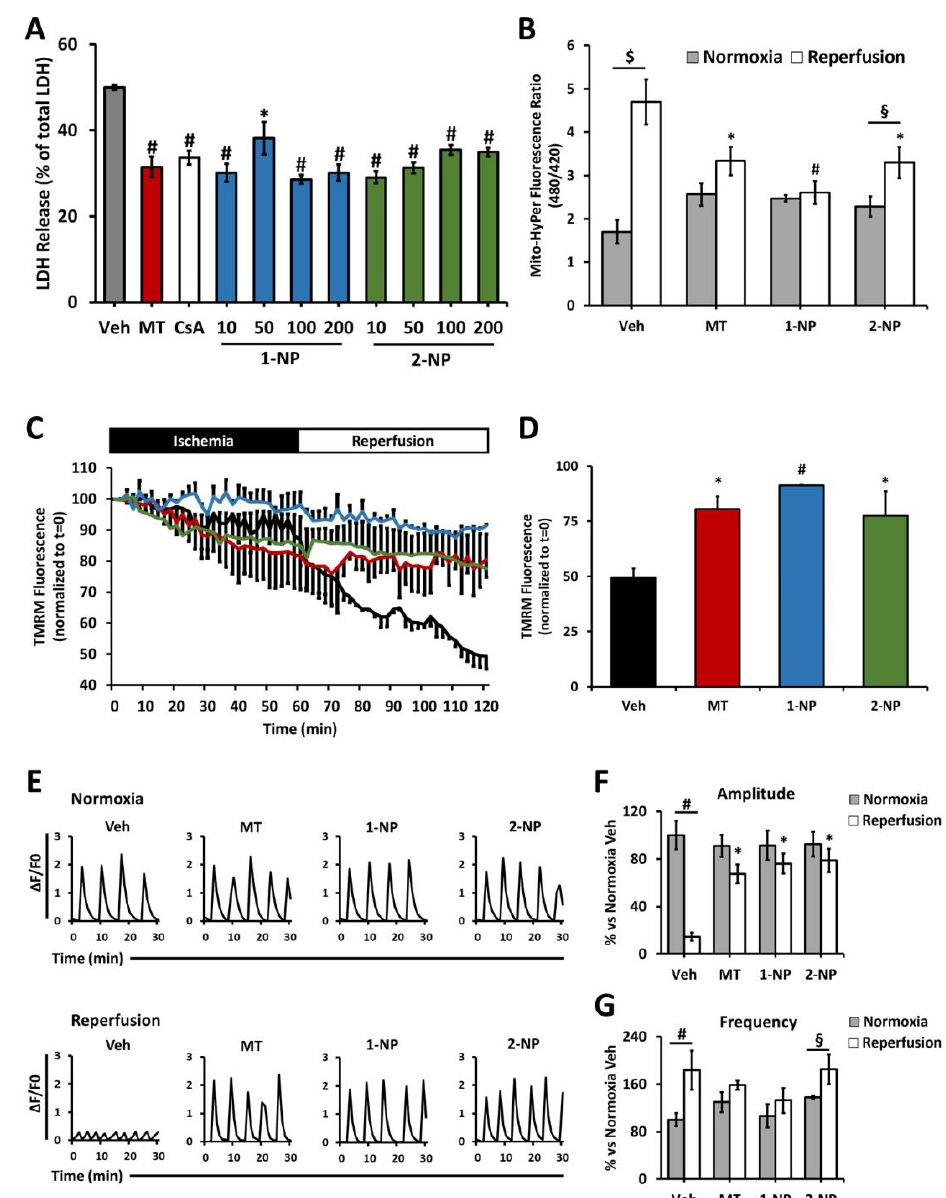
Figure 5. Poly(lipoic acid) NPs protect cardiomyocytes (RNVMs) from ischemia-reperfusion injury. ( A ) Cell death measured by LDH release in reoxygenation from isolated NRVMs. Cells were treated with different concentrations of either F127@ 1 -NP or F127@ 2 -NP. MitoTempo (MT, 10 µM) or cyclo- sporin A (CsA, 2 µM) were used as positive control. * p < 0.01 vs. Veh, # p < 0.001 vs. Veh by one- way ANOVA with post hoc Tukey’s multiple comparison test. ( B ) Mitochondrial H 2 O 2 formation measured by Mito-HyPer in isolated NRVMs subjected to coverslip ischemia. Cells were treated with either F127@ 1 -NP (100 µg/mL) or F127@ 2 -NP (100 µg/mL). MitoTempo (MT 10 µM) was used as positive control. * p < 0.01 vs. Reoxygenation Veh, # p < 0.001 vs. Reoxygenation Veh, § p < 0.05, $ p < 0.001 by two- way ANOVA with post hoc Tukey’s multiple comparison test. ( C ) Mitochondrial membrane potential (ΔΨm) monitored by TMRM fluorescence in isolated NRVMs subjected to co- verslip ischemia. Cells were treated with either F127@ 1 -NP (100 µg/mL) or F127@ 2 -NP (100 µg/mL). MitoTempo (MT 10 µM) was used as positive control. ( D ) ΔΨm was quantified after 60 min of sim- ulated reperfusion. * p < 0.01 vs. Veh, # p < 0.001 vs. Veh by one- way ANOVA with post hoc Tukey’s multiple comparison test. ( E ) Representative intracellular [Ca 2+ ] transients during normoxia (upper panel) and reperfusion (lower panel) in isolated NRVMs subjected to coverslip ischemia. Cells were treated with either F127@ 1 -NP (100 µg/mL) or F127@ 2 -NP (100 µg/mL). MitoTempo (MT 10 µM)